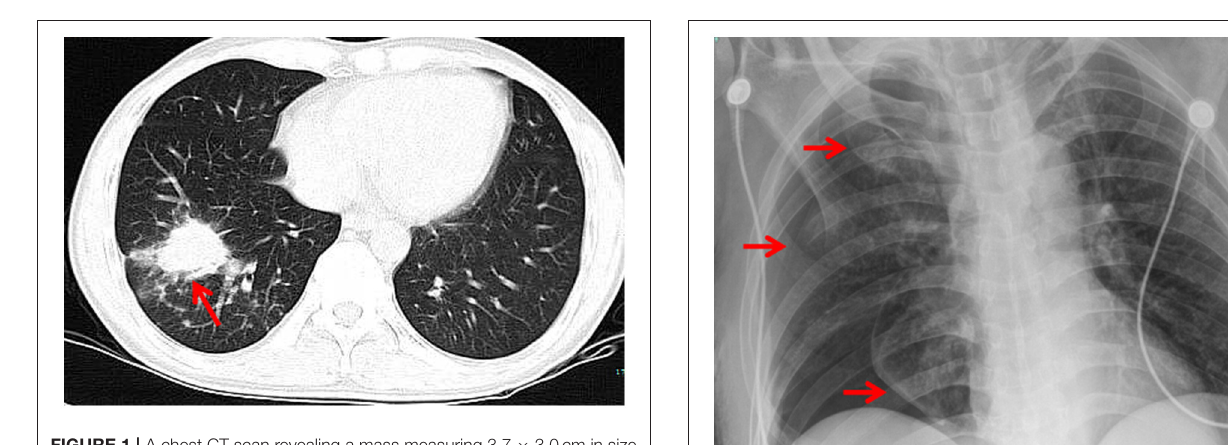
2 months. Unfortunately, the mass did not shrink ( Figure 2